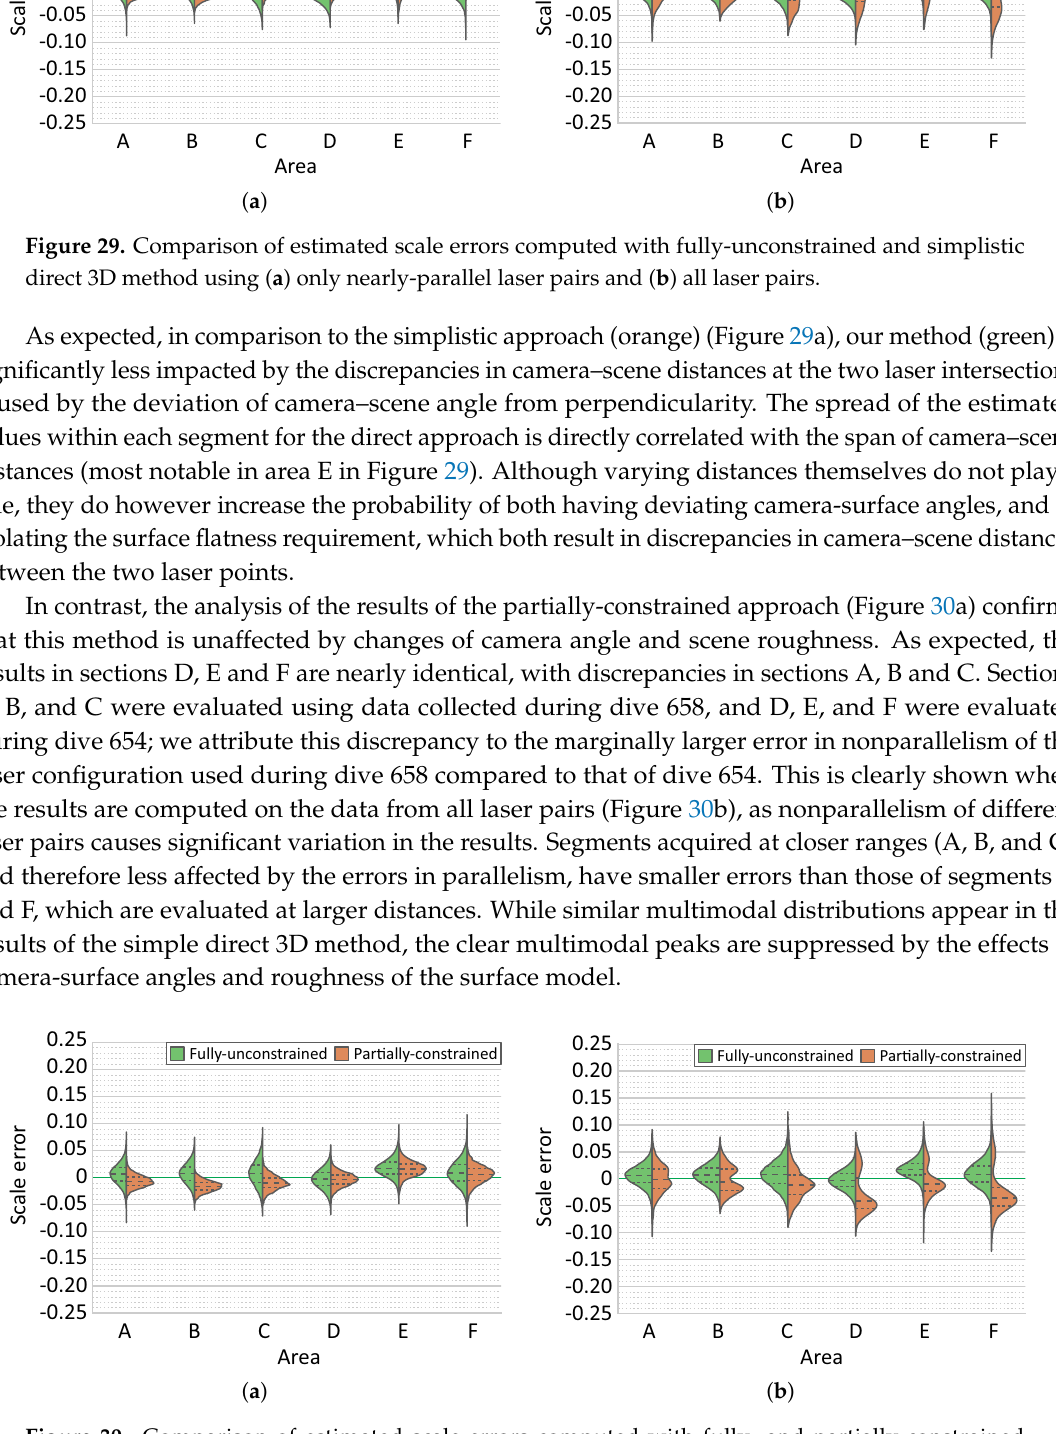
Figure 30. Comparison of estimated scale errors computed with fully- and partially-constrained method using ( a ) only nearly-parallel laser pairs; ( b ) all laser